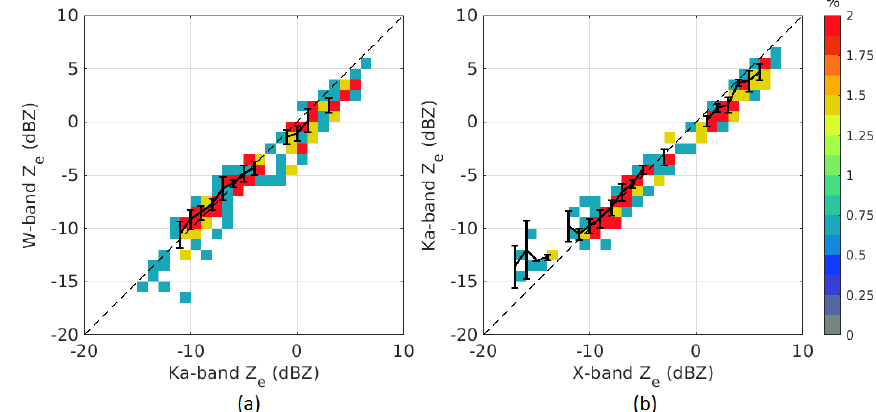
Figure 4. Scatterplots of (a) W-band and Ka-band as well as (b) Ka-band and X-band cross-calibrated reflectivities at 245m from the nadir antennas for the 22 November flight. The data are thresholded by MVD < 300µm and are binned on a 2D grid with a grid size of 0.5dB. The dashed black line is the 1 : 1 line. The solid black lines are the mean curve and 1 standard deviation error bars. Table 2. CPI classification grouping